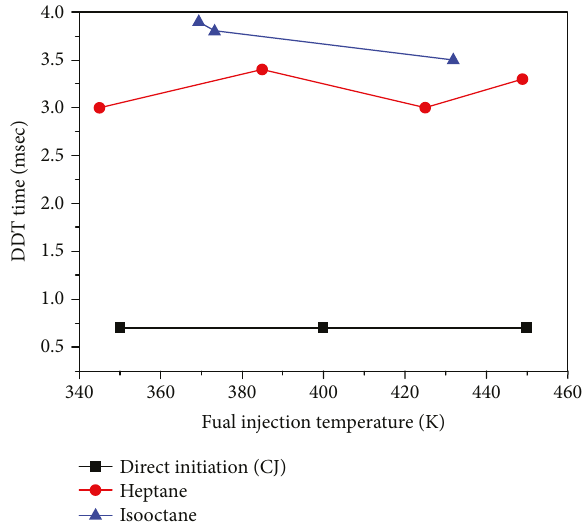
Figure 11: The DDT time of the heptane and isooctane